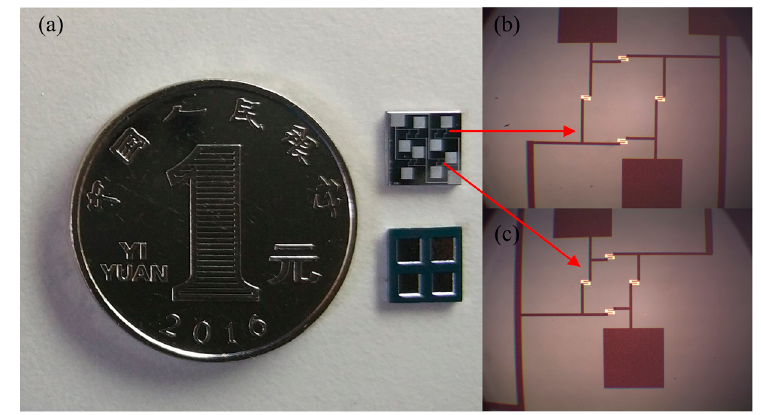
Figure 9. ( a ) Physical map of array-type pressure sensor; ( b ) a photograph of the fabricated PS1/PS2 pressure sensor; and ( c ) a photograph of the fabricated PS3/PS4 pressure sensor.